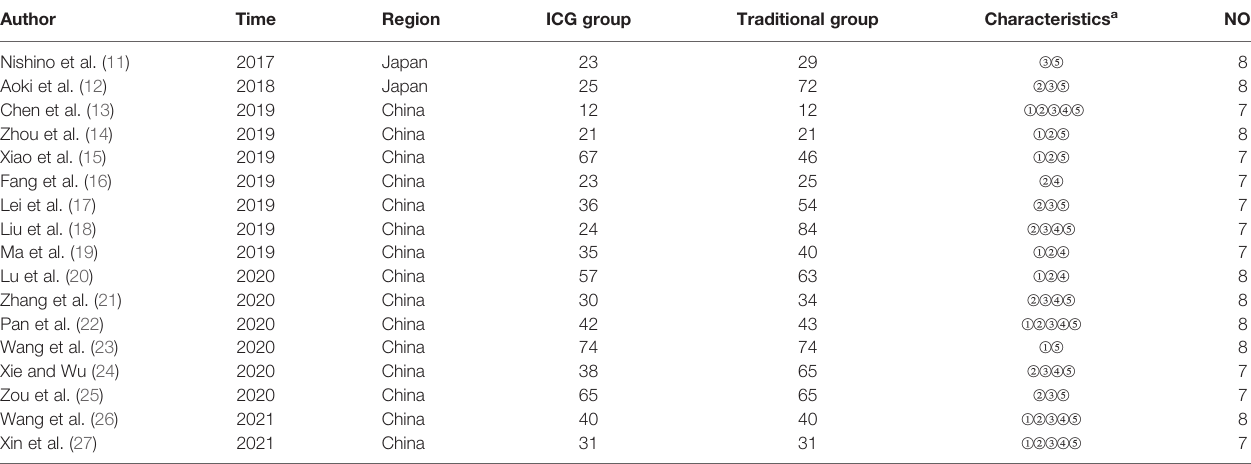
TABLE 5 | Basic characteristics of the included studies.